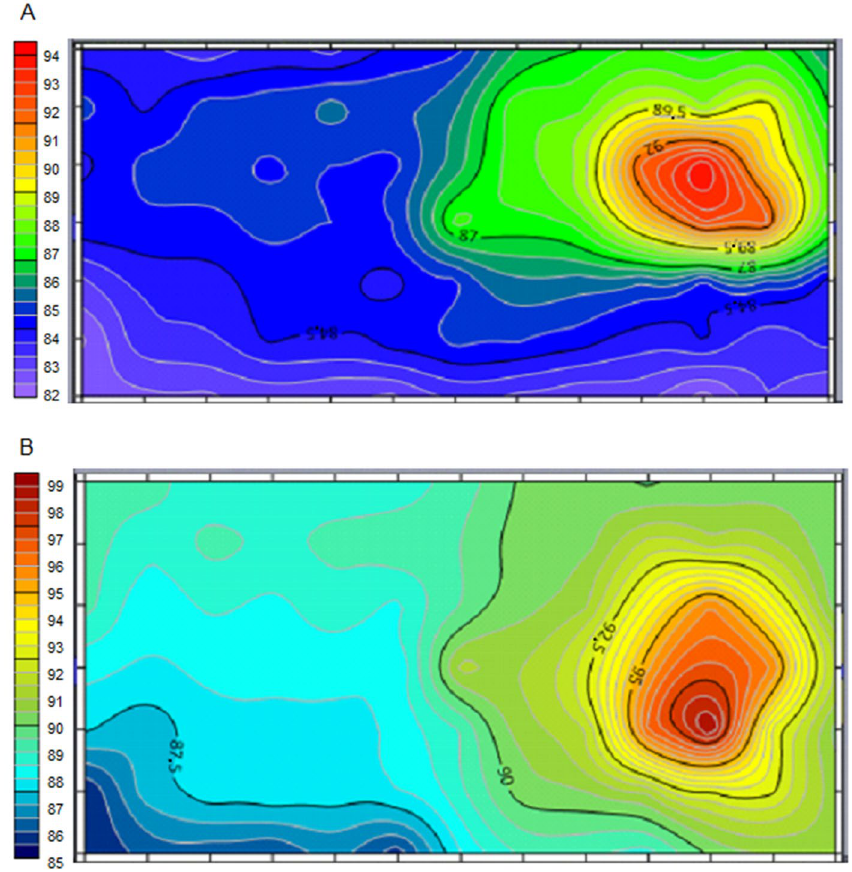
Figure 6. Noise level map measurement results at grain unloading and cleaning area with one machine ( A ) operation and two machines operation ( B ).